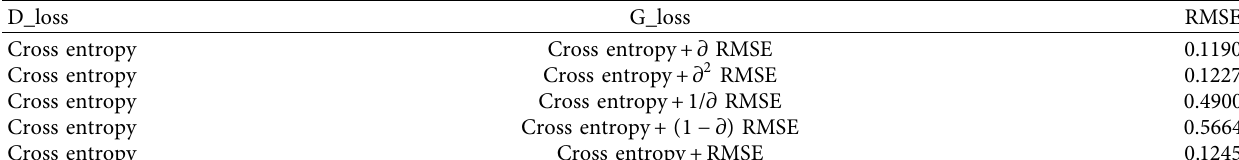
Table 4: The influence of the parameters in the loss function on model performance.